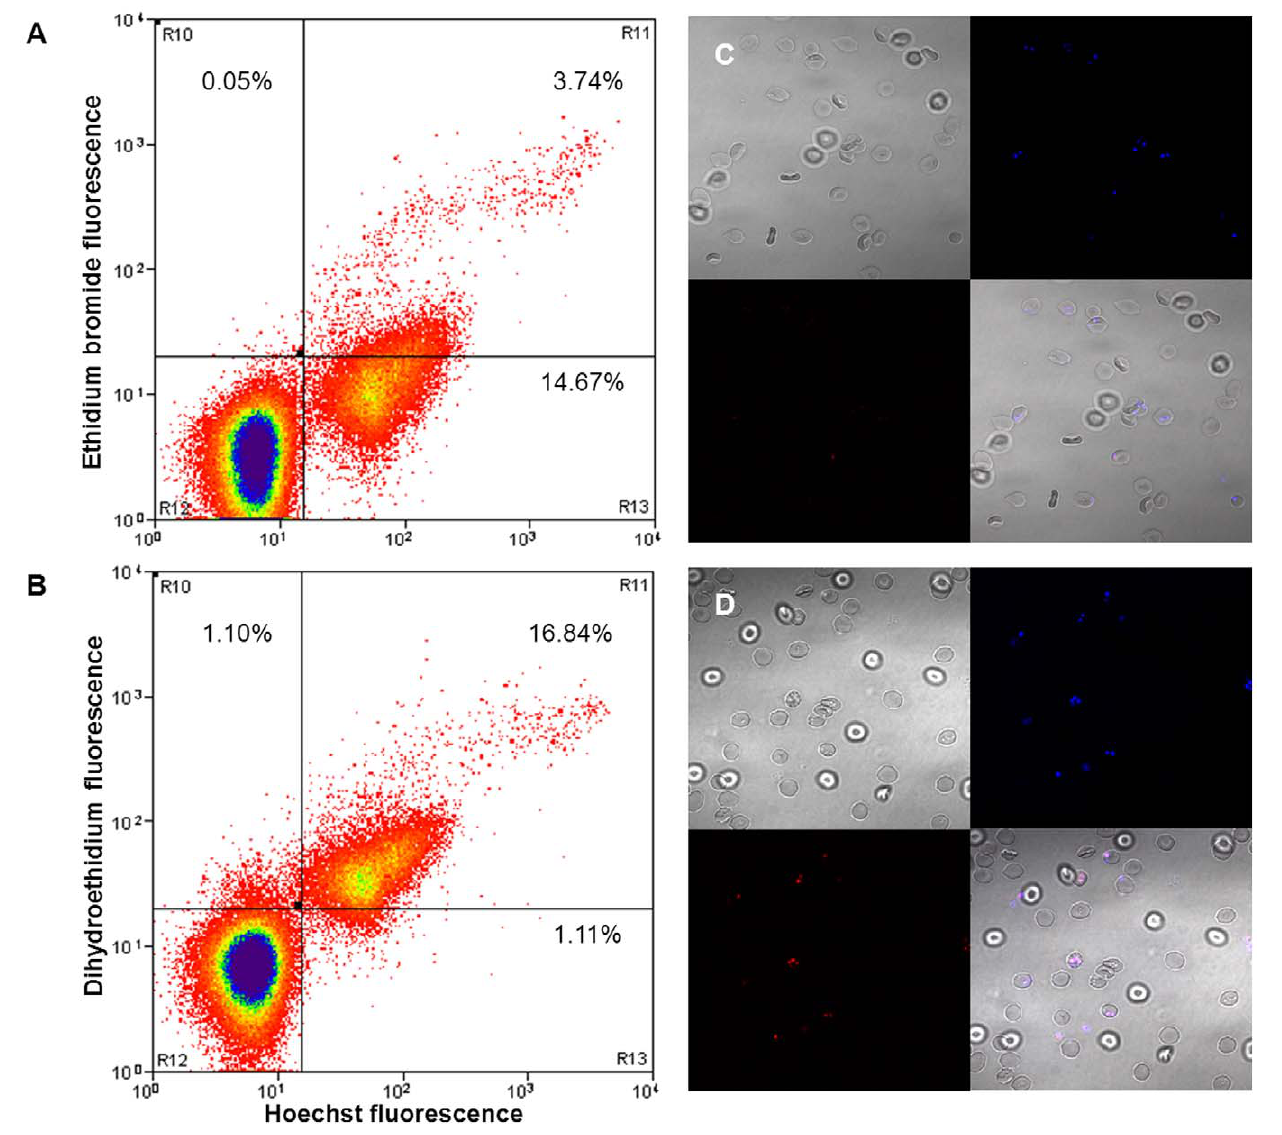
Figure 2. Comparison between EB and DHE labeling, using Hoechst 33342 as a comparator. Ring-staged Plasmodium falciparum cultures at 20% parasitemia, 1% hematocrit were labeled with ( A, C ) 10 m g/ml EB or ( B, D ) 5 m g/ml DHE, both of which were co-stained with 1 m g/ml Hoechst 33342, for 20 min at 37 u C before analysis using flow cytometry and confocal imaging. A ) Only about 20% of Hoechst-labeled iRBCs were stained with EB whereas B ) more than 90% of Hoechst-labeled iRBCs were stained with DHE.